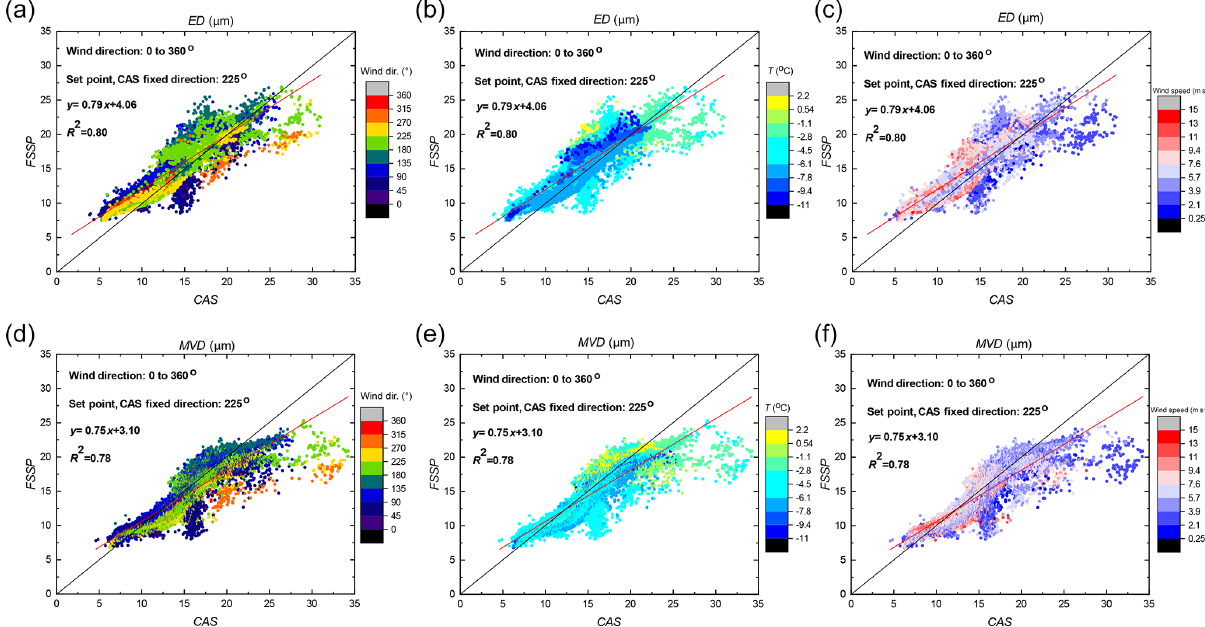
Figure 11. Comparison of ED (a , b, c) and MVD (d, e, f) as it was derived from the CAS and FSSP is presented for all wind directions. Color code represents wind direction ( a and d ), temperature ( b and e ), and wind speed ( c and f